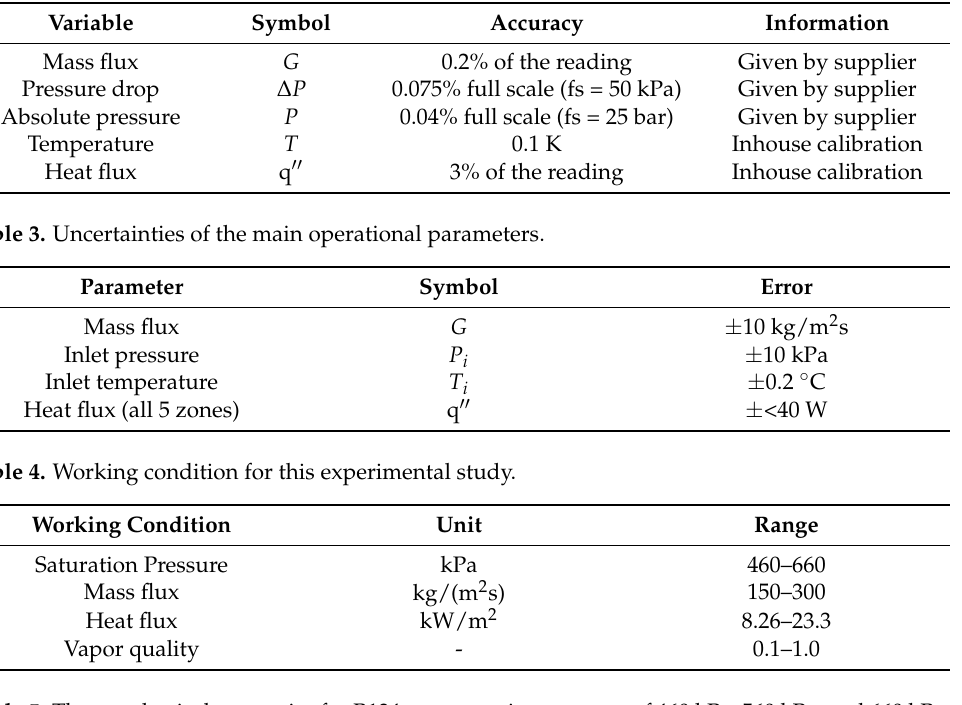
Table 5. Thermophysical properties for R134a at saturation pressure of 460 kPa, 560 kPa, and 660